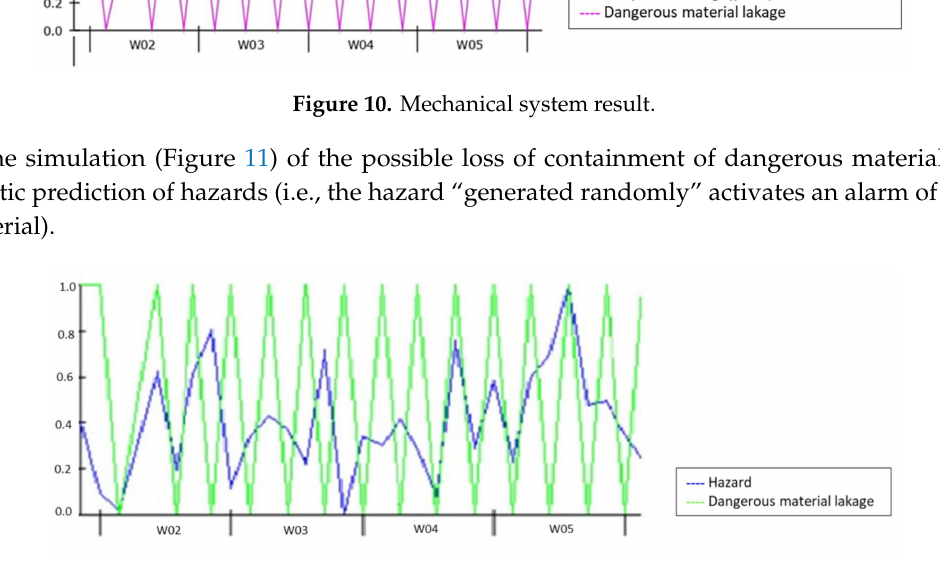
Figure 11. Loss of dangerous material and prediction of leakage of hazardous material.